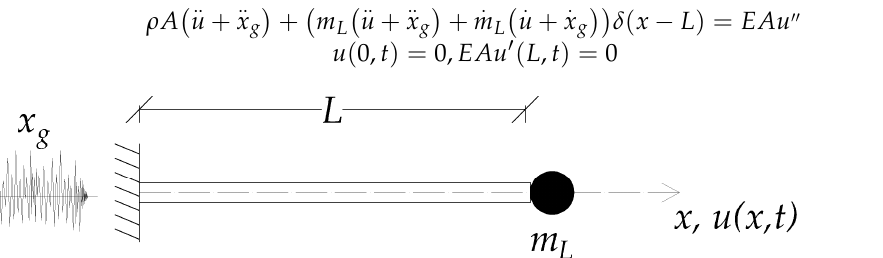
Figure 1. Flexible pylon of length L with an attached point mass m L at the top and subjected to ground vibrations in the longitudinal direction x